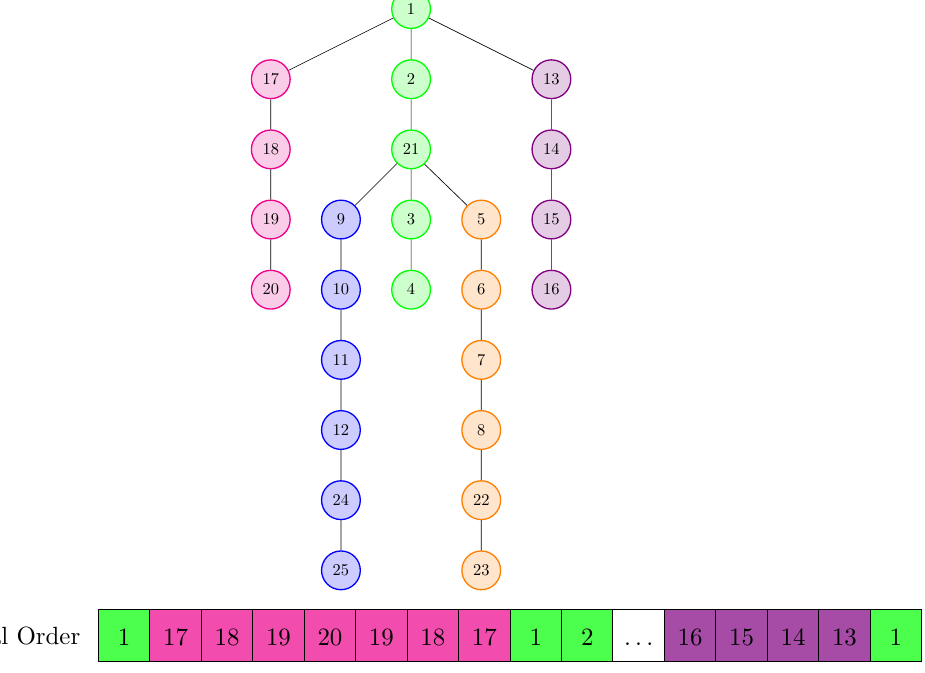
Figure 4. Transformation of the skeleton into a tree having the root of joint 1 (considered the centre of gravity). This tree is used for linearizing the skeleton (made based on a depth traversal applied to the